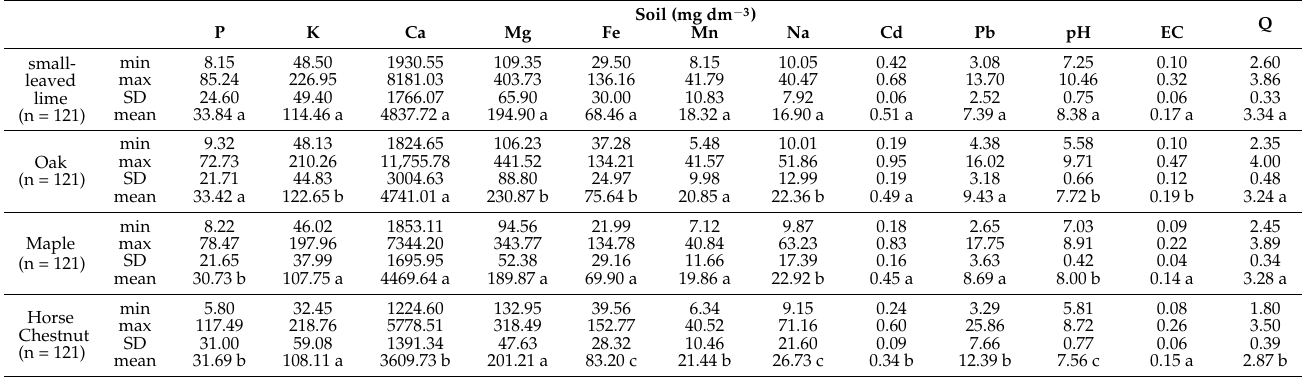
Table 4. Minimum, maximum, average values, and standard deviations for the tested parameters in soil (Q—trees’ health condition).